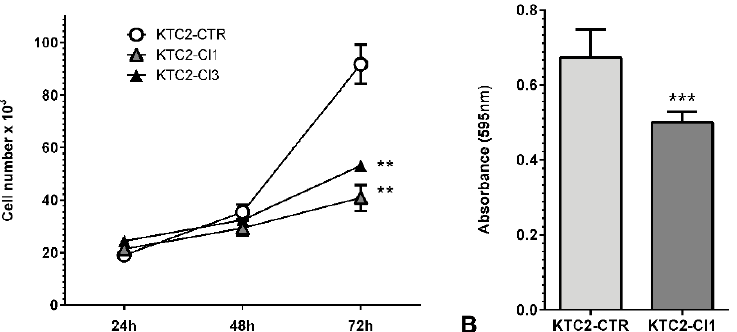
Figure 4. ( A ) Cell counting of KTC2-Cl1 and Cl3. Cell number was accessed at 24 h, 48 h, and 72 h after plating in comparison to KTC2-CTR. The results are representative of two independent experiments performed in triplicate. ( B ) Cell viability assay of KTC2-Cl1 and KTC2-CTR was evaluated using MTT and absorbance was measured at 595 nm. ** p < 0.05 vs. KTC2-CTR *** p < 0.01 vs. KTC2-CTR.